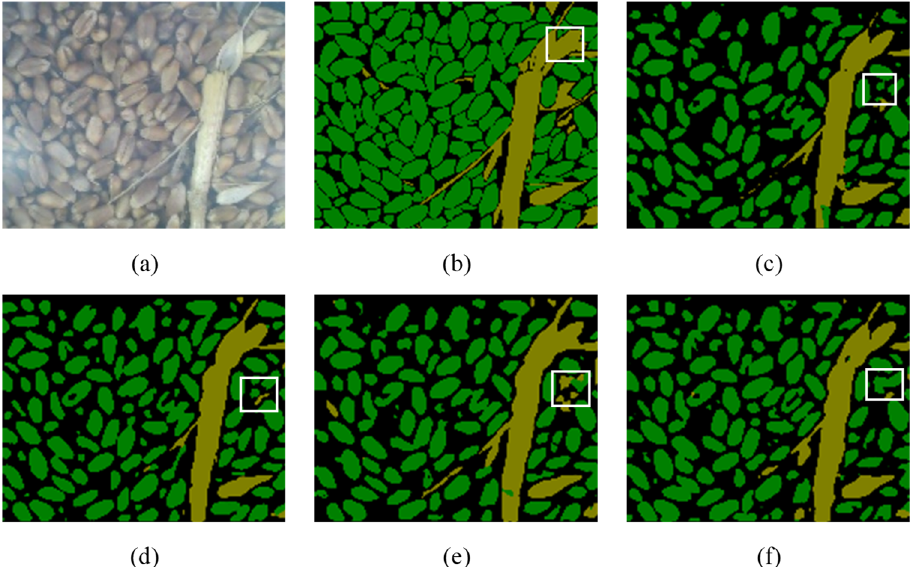
Figure 6. Different backbone network identification and segmentation effects. ( a ) Original image; ( b ) manually labeled image; ( c ) MobileNetV2; ( d ) Xception-65; ( e ) ResNet-50; ( f ) ResNet-101.